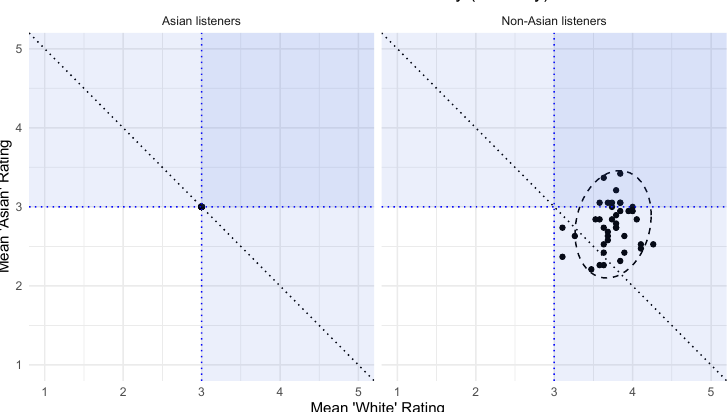
Figure 9. Without audio, and only given text to read, the non-Asian post-hoc experiment participants still rated most speakers as likely to be White and not likely to be Asian. One participant in the post-hoc study was Korean and rated almost every speaker as